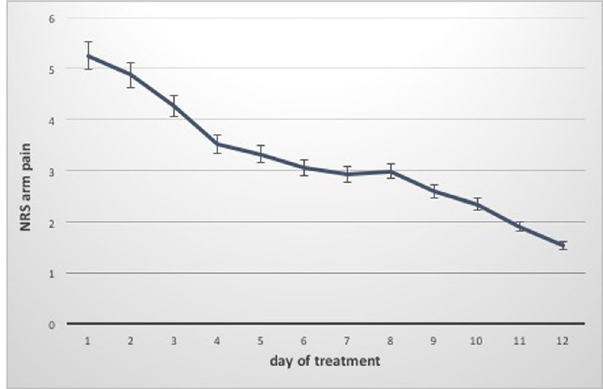
Figure 4. Course of arm pain during hospitalization (Median and